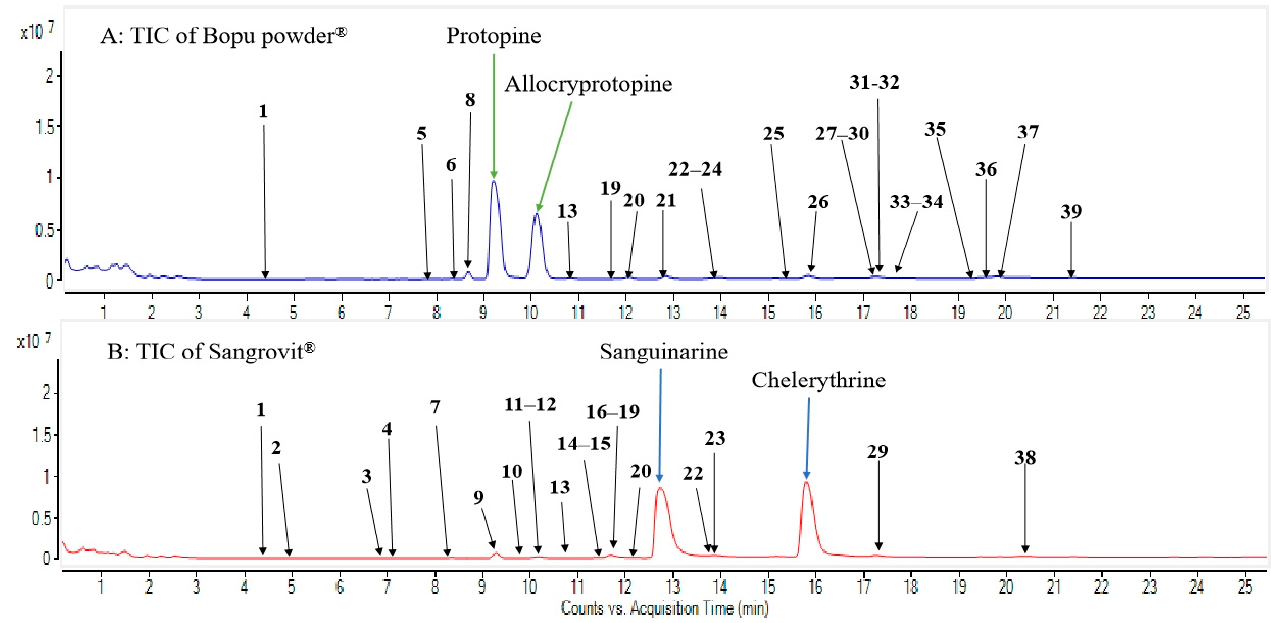
Figure 1. Diagram of systematic screening the impurities from Bopu powder ® and Sangrovit ® . X , Y , Z , and M represent the number of hydrogen (H), hydroxy (OH), methyl (CH 3 ) and carbon monoxide (CO), respectively.